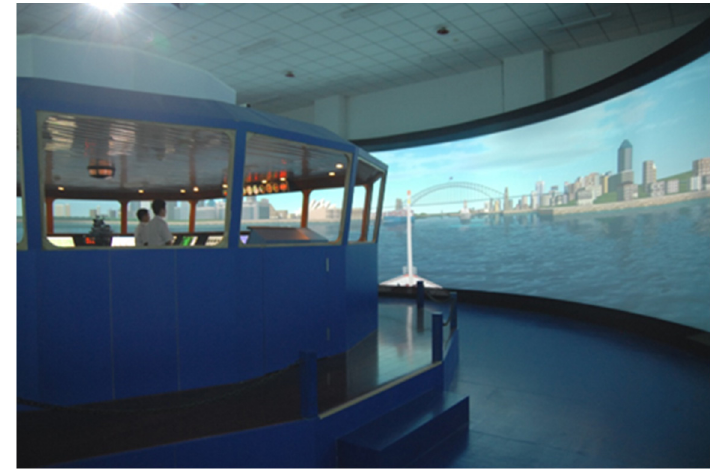
Figure 1. Location map of marine simulator.